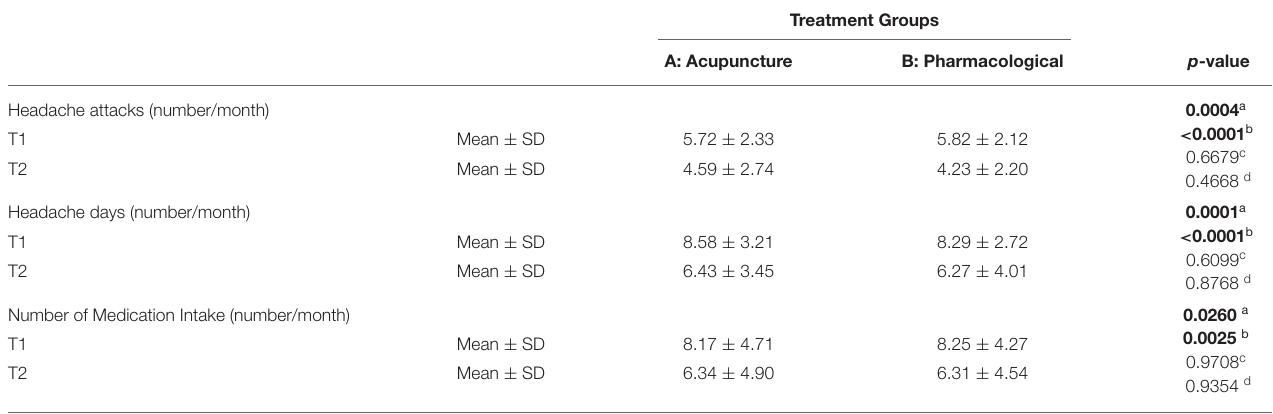
TABLE 2 | Clinical features at the time of randomization and after treatment of the two